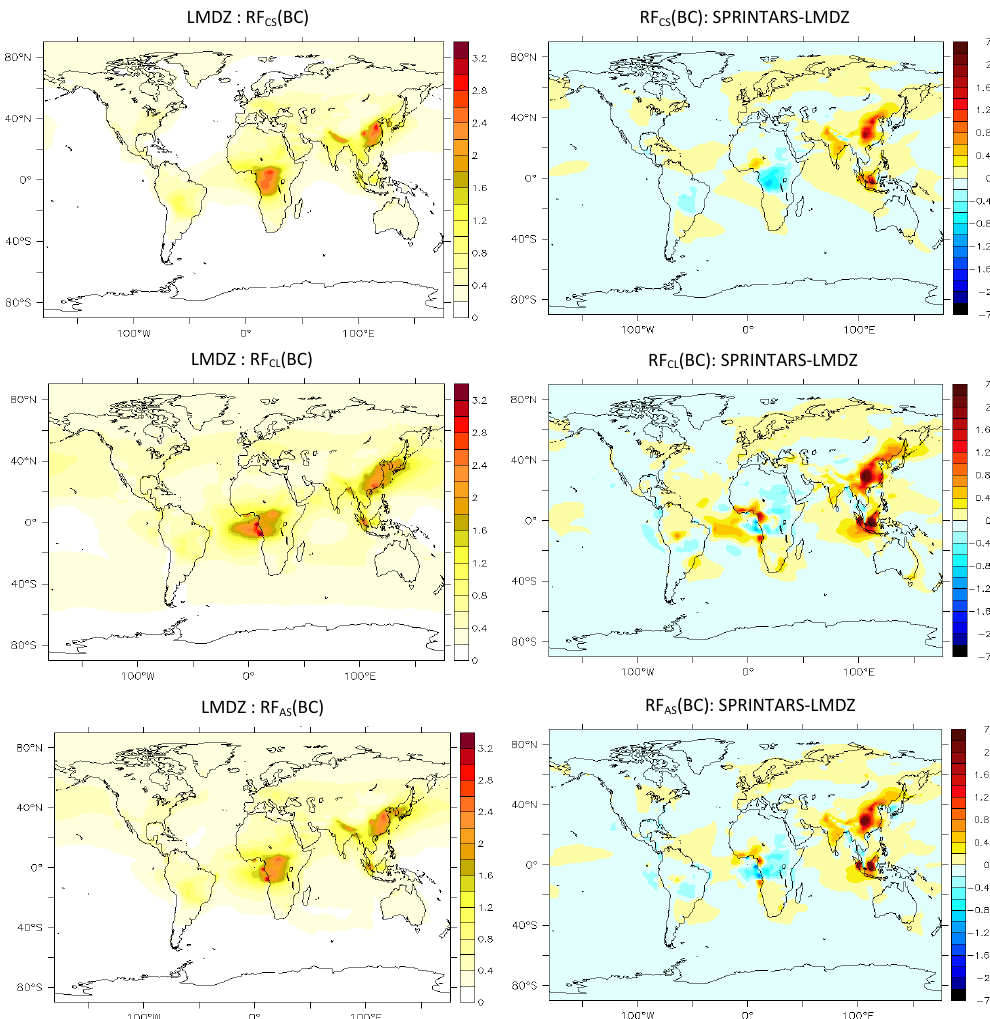
Fig. 5. Left column: reading LMDz values of BC forcings. Right column: reading SPRINTARS minus reading LMDz BC forcings. Top to bottom: clear-, cloudy- and all-sky values (RF CS , RF CL , RF AS [Wm − 2 ]).